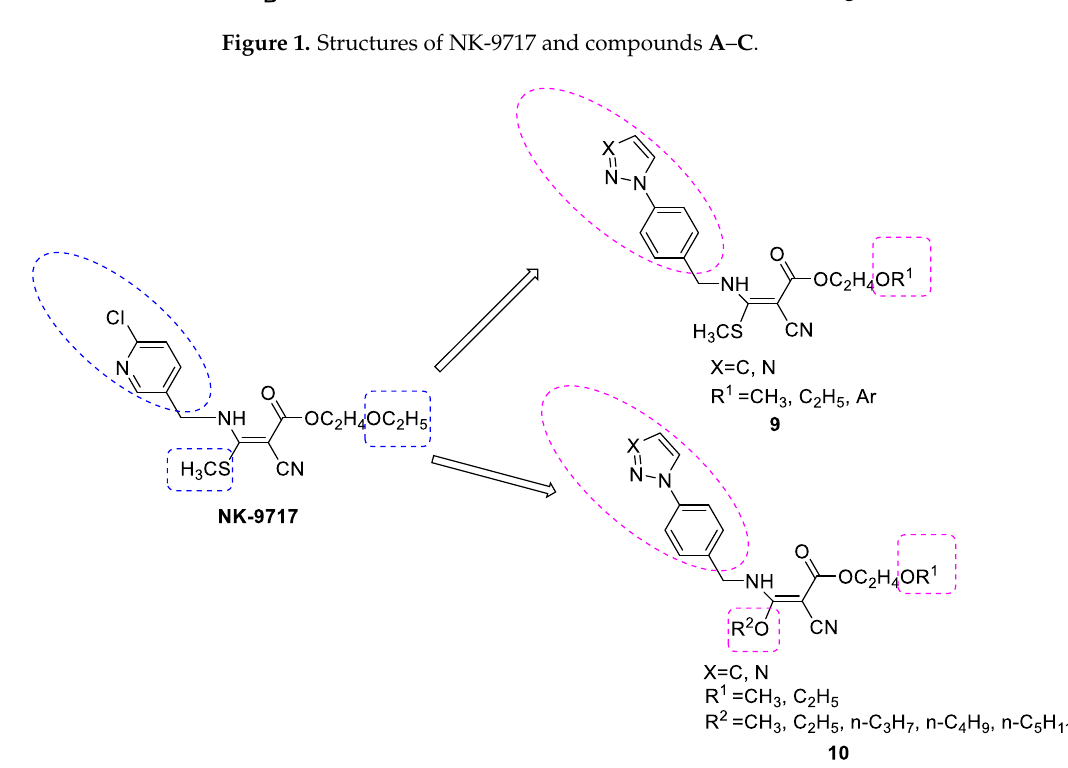
Figure 2. Design strategy of 2-cyanoacrylate derivatives 9 and 10 .